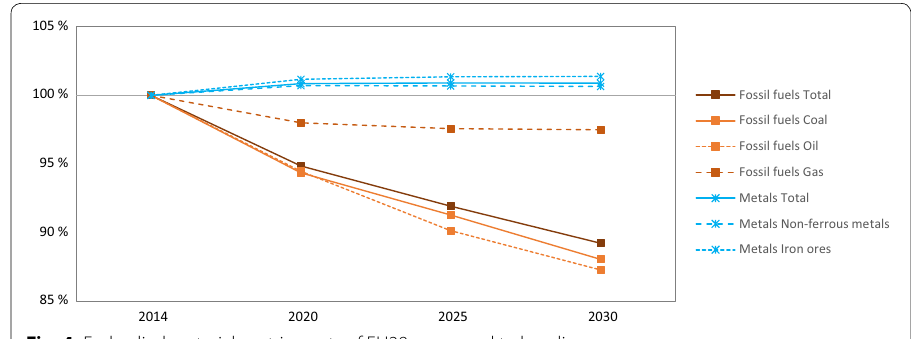
Fig. 4 Embodied materials net-imports of EU28 compared to baseline